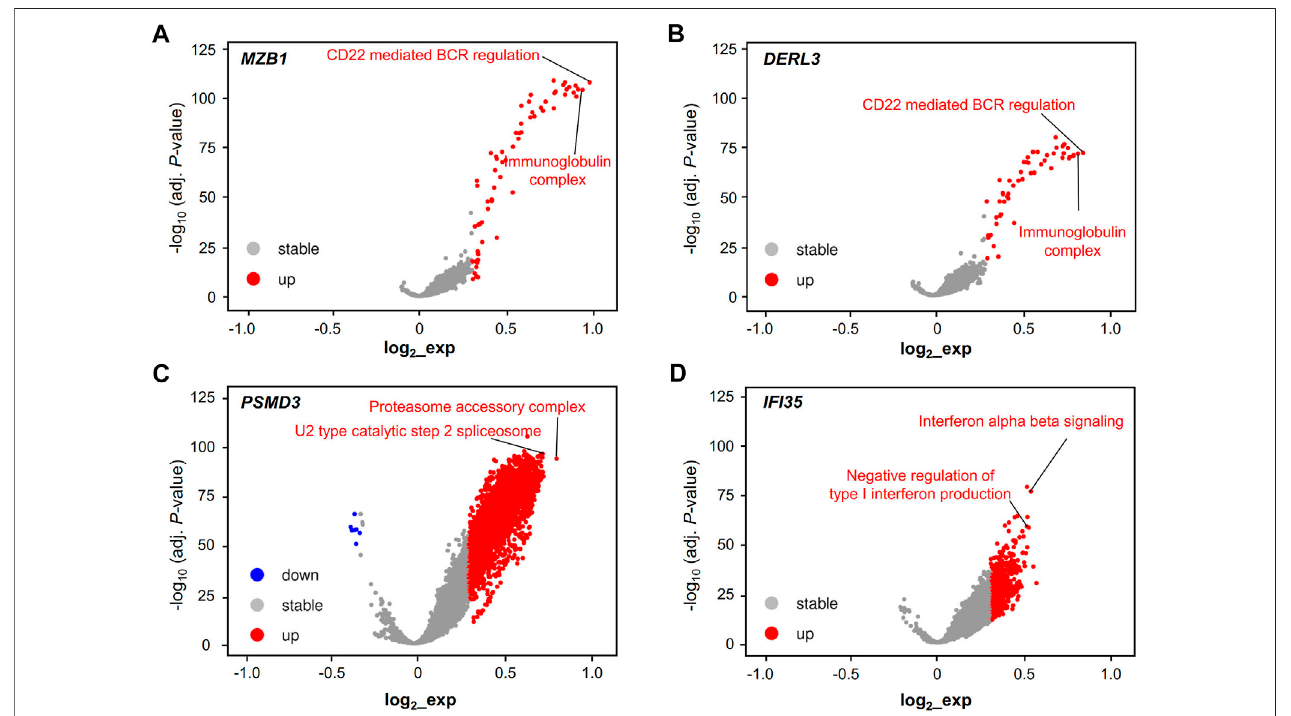
FIGURE5| Validationofthecelltypeandfunctionofhubgenes.FunctionalvolcanoplotofRRhubgenesMZB1 (A) andDERL3 (B) andRShubgenesPSMD3 (C) and IFI35 (D) in the TCGA-LUAD dataset. Gene set variation analysis (GSVA) and the “ Limma ” R package were used to fi ndthe different essential pathways of LUAD for the single hub genes, including MZB1, DERL3, PSMD3, and IFI35. Adjusted p < 0.001 and log 2 (fold change) > |0.3| were regarded as statistically signi fi